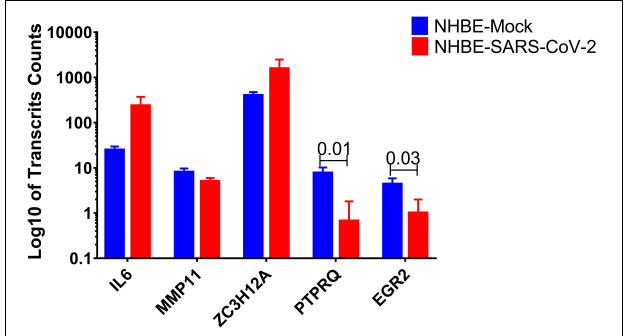
FIGURE 3 | PTPRQ and EGR2 are decreased in SARS-CoV-2 infected epithelial cells. Log10 of transcripts counts of the genes related to the regulation of fat cell differentiation IL6, MMP11, ZC3H12A, PTPRQ, and EGR2 in infected cells compared to mock-infected epithelial